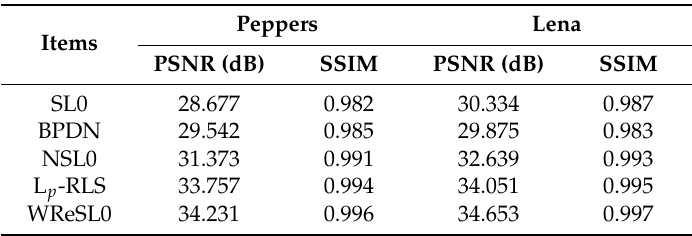
Table 4. PSNR and SSIM analysis of recovered images (peppers and Lena) by SL0, BPDN, NSL0, L p -RLS, and WReSL0.